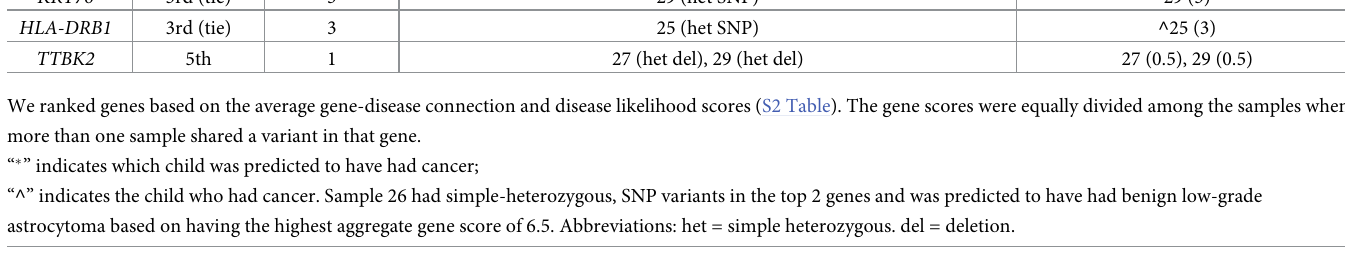
Table 2. Top five candidate genes for Family 1 (benign low-grade astrocytoma).